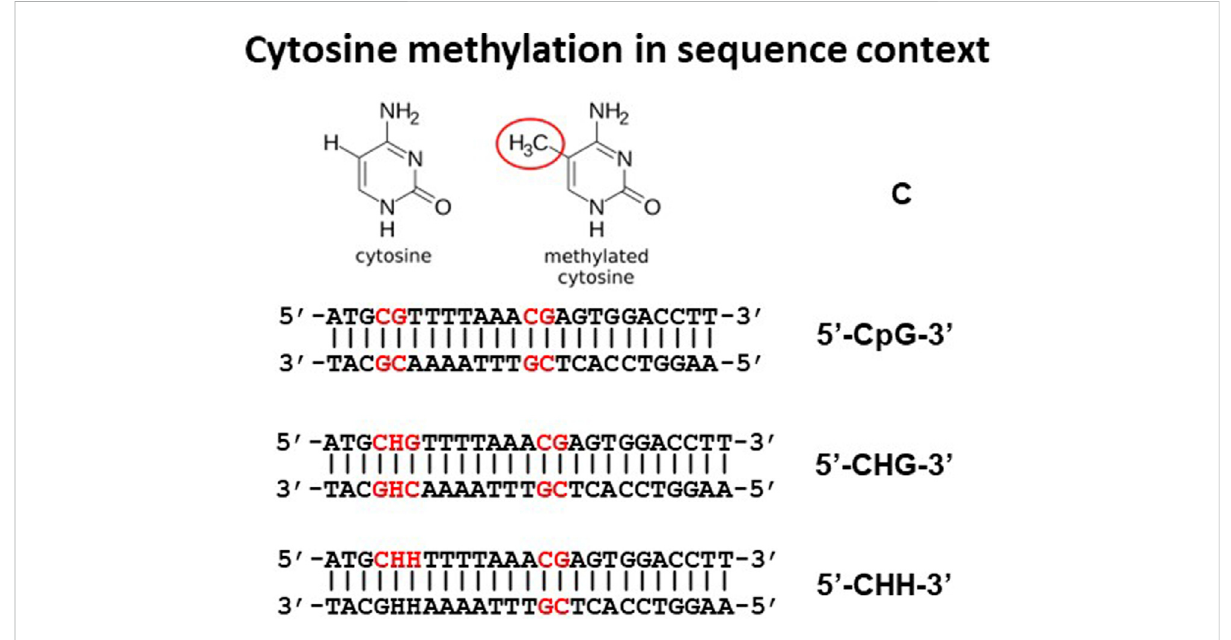
FIGURE 2 Cytosines within DNA can be within CpG, CHG, or CHH context where H is A, C, or